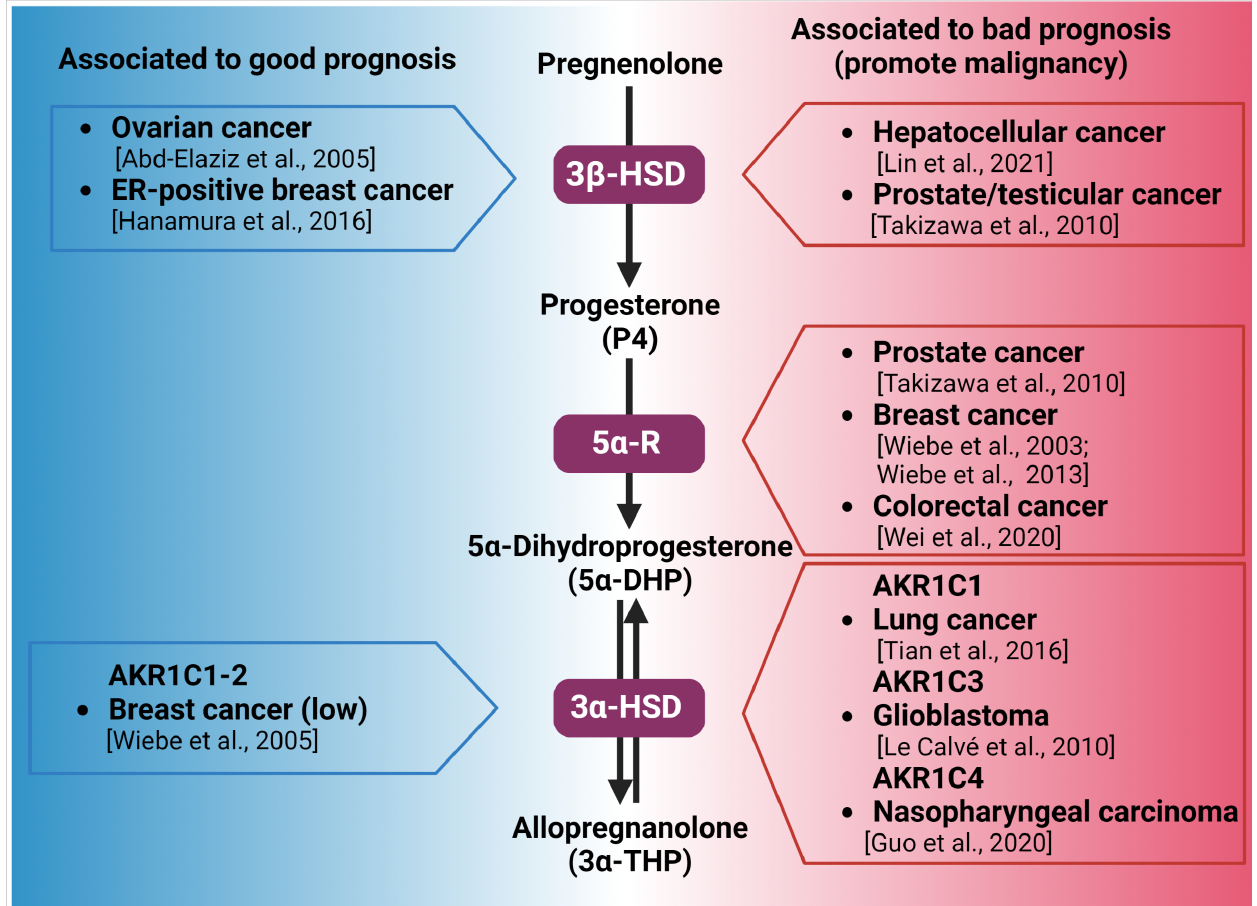
Figure 2. Synthesis of 3 α -THP from pregnenolone and the alteration of the expression of the in- volved enzymes in different types of cancer. Enzymes participating in each metabolic step are indicated by purple squares. On the left side (blue), the association between the high expression of 3 β -HSD, 3 α -HSD, and good prognosis of patients with different types of cancer is indicated. In the right side (red space), the different types of cancer in which the high expression of 3 β - HSD, 3 α -HSD, and 3 α -HSD isozymes are related to poor prognosis and cancer progression are presented